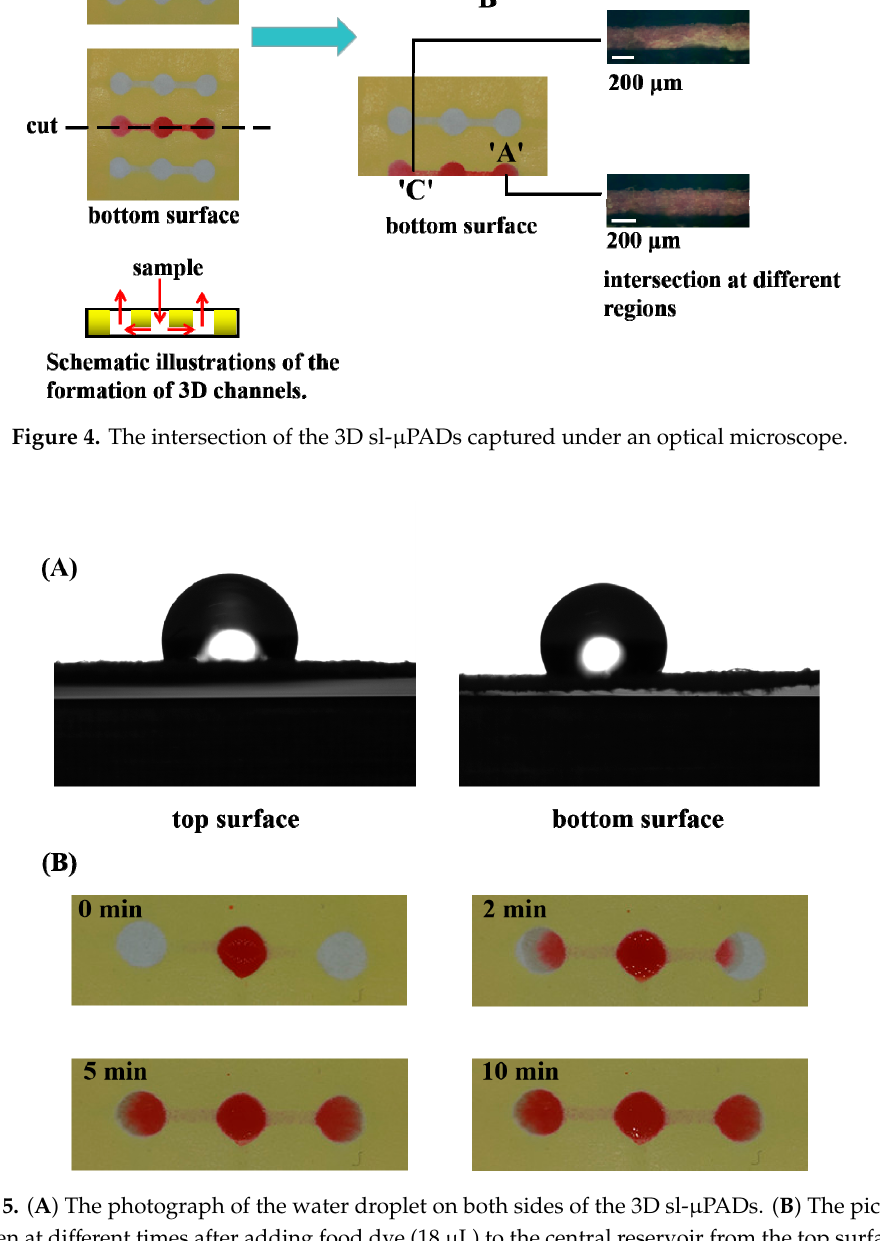
Figure 5. ( A ) The photograph of the water droplet on both sides of the 3D sl- µ PADs. ( B ) The pictures are taken at di ff erent times after adding food dye (18 µ L) to the central reservoir from the top surface of the 3D sl- µ